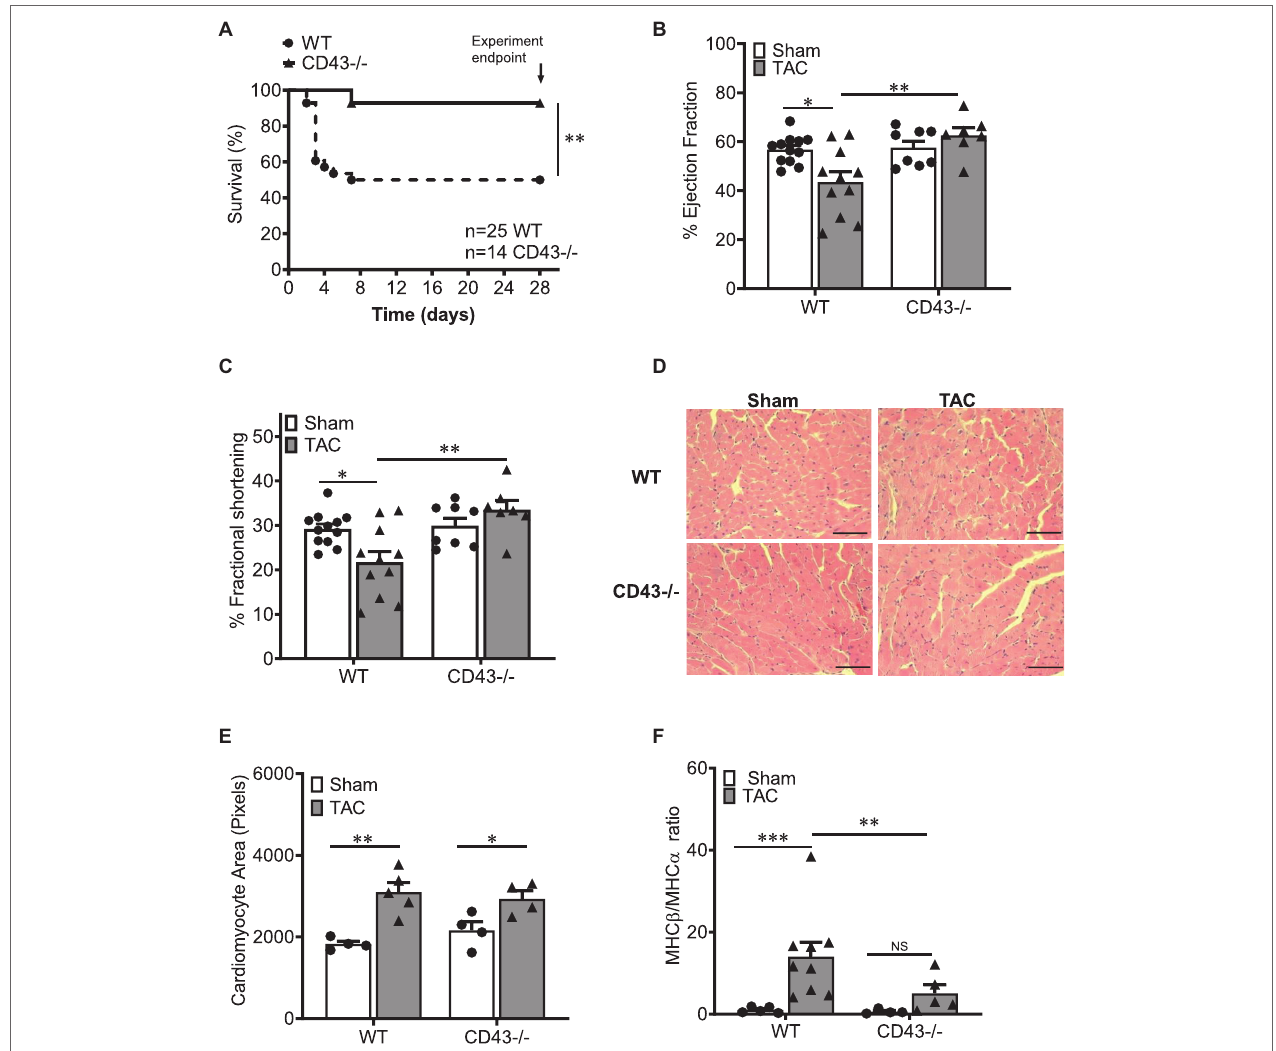
FIGURE 1 | CD43 − / − mice are protected from systolic heart failure. (A) . Kaplan–Meier survival curves in WT and CD43 − / − mice after TAC surgery. Survival curves were compared by log-rank (Mantel–Cox) test n = number of animals in survival curve data. Changes in ejection fraction (EF; B ) and fractional shortening (FS; C ) in response to TAC in WT and CD43 − / − mice as measured by echocardiography. (D) Representative images of WT and CD43 − / − LV section in Sham and TAC mice. Scale bars,